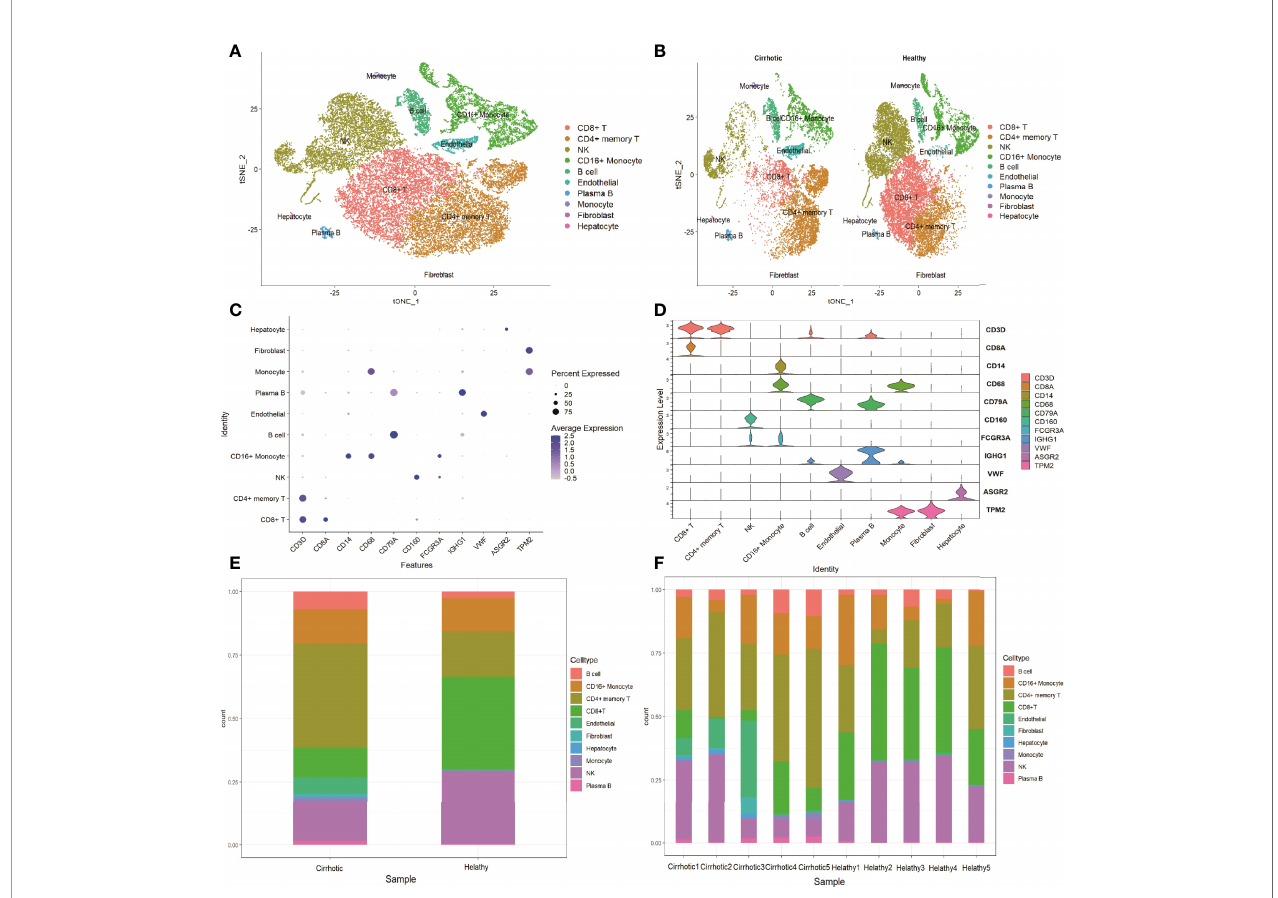
FIGURE 2 | Marker gene expression of each cluster. (A) tSNE projection of all liver CD45+ leukocytes. Different cell types were colored with unique colors. (B) tSNE projection of the cirrhotic group and the control group. (C) Dot plot of cell type marker genes. Cell speci fi c marker genes were selected according to previous studies. The color of the dots represents the average expression, and size of dots represents average percentage of cells expressing the selected gene. (D) Violin plot depicts the distributions of cell type marker genes in each cluster using density curves. The width of each violin plot corresponds to the frequency of cells with relevant gene expression levels. (E) Cluster distribution in the two groups. (F) Cluster distribution in each